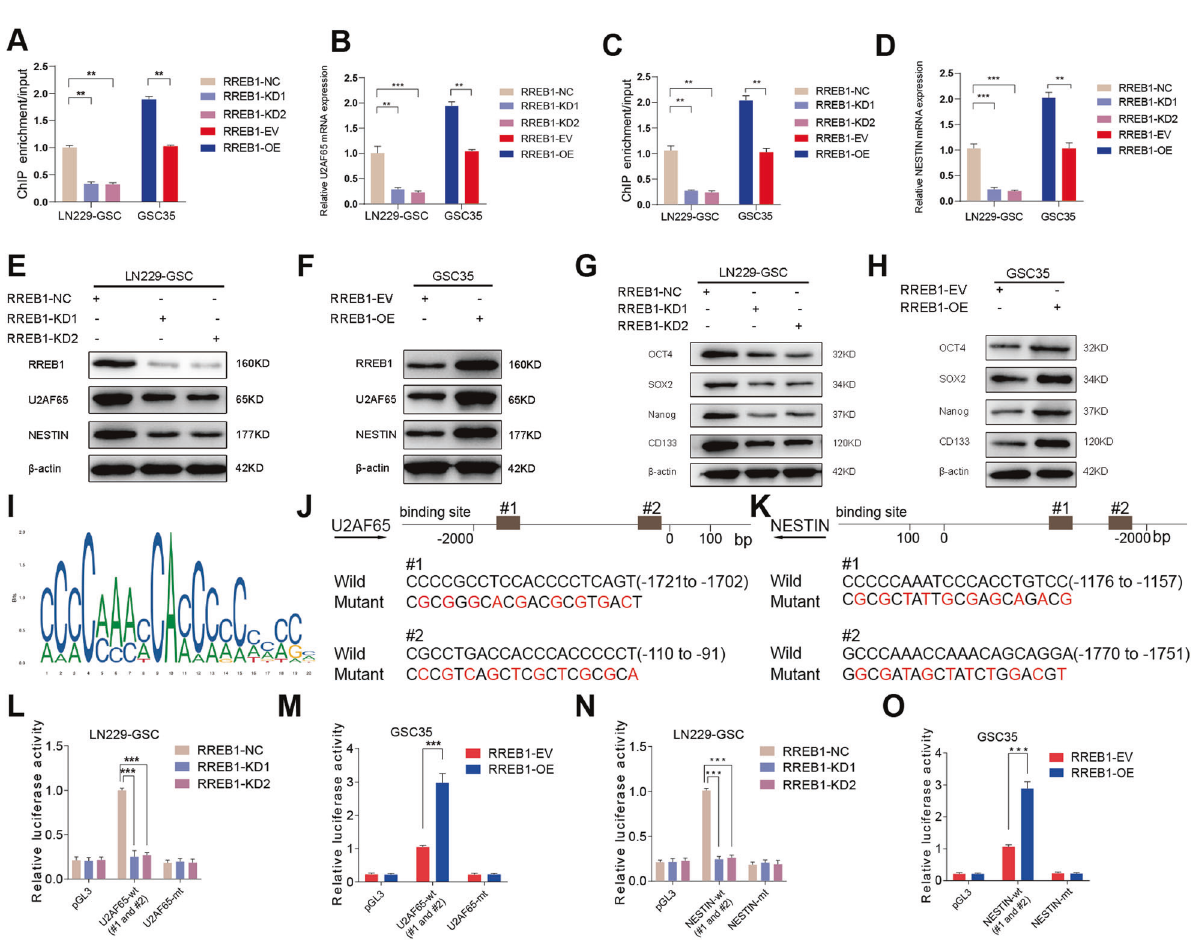
Fig. 6 RREB1 transcriptionally upregulates U2AF65 and NESTIN expression and maintains the stemness of GSCs. A , C The ChIP qPCR assays revealed that RREB1 directly binds to the promoter of U2AF65 ( A ) and NESTIN ( C ). B , D The qPCR assays revealed the mRNA expression levels of U2AF65 ( B ) and NESTIN ( D ) in GSCs with RREB1 knockdown and overexpression treatment. E , F The western blotting revealed RREB1, U2AF65, NESTIN protein levels in GSCs with RREB1 knockdown ( E ) and overexpression ( F ) treatment. G , H Stemness markers were detected via western blotting in GSCs with RREB1 knockdown ( G ) and overexpression ( H ) treatment. I The diagram of RREB1 binding motif (JASPAR database). J , K The presumed RREB1 binding site in U2AF65 ( J ) and NESTIN ( K ) promoter. L – O The luciferase reporter assays revealed that RREB1-KD or RREB1-OE in fl uenced the luciferase promoter activities of U2AF65 ( L , M ) and NESTIN ( N , O ). All results are presented as the mean ± SD (three independent experiments). * p < 0.05; ** p < 0.01; *** p <